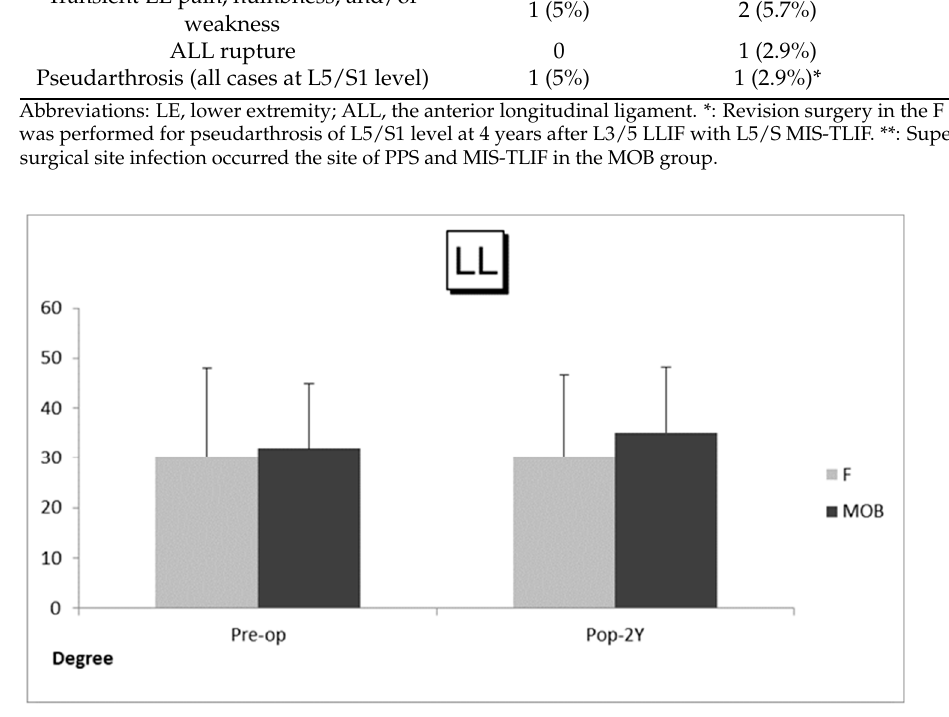
Figure 2. Sagittal vertebral axis (SVA) in the MOB patient group (MOB group) and the first surgical patient group (F group). The bars depict preoperative and follow-up average values and standard deviations in each group. Abbreviations: Pre-op, before surgery; Pop-2Y, at 2 years after surgery. The preoperative JOABPEQ averaged 36.3 points in the MOB group and averaged 35.4 points in the F group. The postoperative average JOABPEQ was 75.4 in the MOB group and 70.2 in the F group. The preoperative JOA scores averaged 12.5 points in the MOB group, and averaged 11.6 points in the F group. The postoperative JOA scores aver- aged 23.9 points in the MOB group, averaged 24.7 points in the F group. In comparing the clinical outcomes, the JOABPEQ and the JOA scores were significantly improved after surgery compared with before surgery in both groups, but no significant difference was observed between the two groups ( p = 0.474 in the JOABPEQ, p = 0.327 in the JOA scores) (Figure 3). No major complications were observed, and there were no characteristic com- plications concerning LLIF in each group (Table 2).